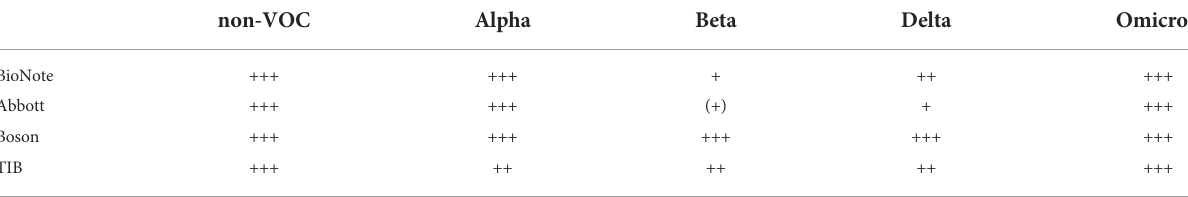
TABLE 5 Detection of 100 ng recombinant N-protein of non-VOC and VOCs by